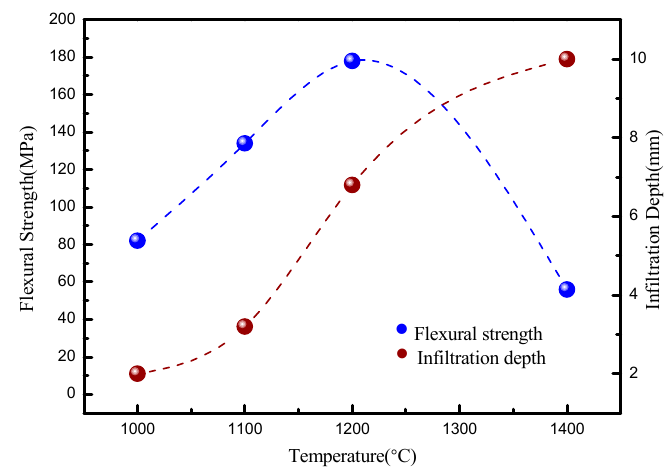
Figure 4. The effect of vacuum heat treatment on flexural strength and infiltration depth (B0, B1, B2, and B4 for 1000, 1100, 1200, and 1400 °C, respectively) of C/C–Al–Mg.